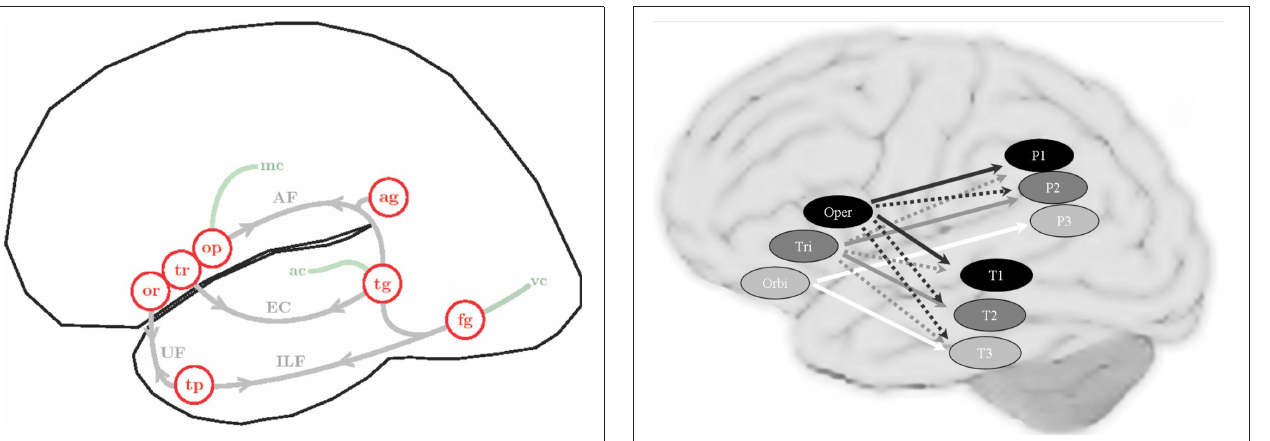
FIGURE 6 | The topographical connectivity pattern between frontal and temporal/parietal cortex in the perisylvian language networks. Connections to the left pars opercularis (oper), pars triangularis (tri) and pars orbitalis (orbi) are shown in black, dark gray and white arrows respectively. The solid arrows represent the main (most significant) correlations and the dashed arrows represent the extending (overlapping) connections. Brain areas assumed to be mainly involved in phonological, syntactic and semantic processing are shown in black, dark gray and light gray circles, respectively. P1: Supramarginal gyrus; P3: AG: Angular gyrus; P2: the area between SMG and AG in the superior/inferior parietal lobule; T1: posterior superior temporal gyrus; T2: posterior middle temporal gyrus; P3: inferior temporal